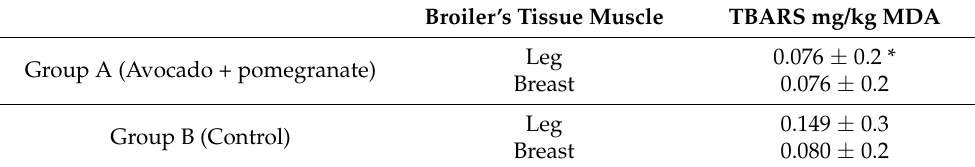
Table 2. Effects on oxidative stress markers (TBARS